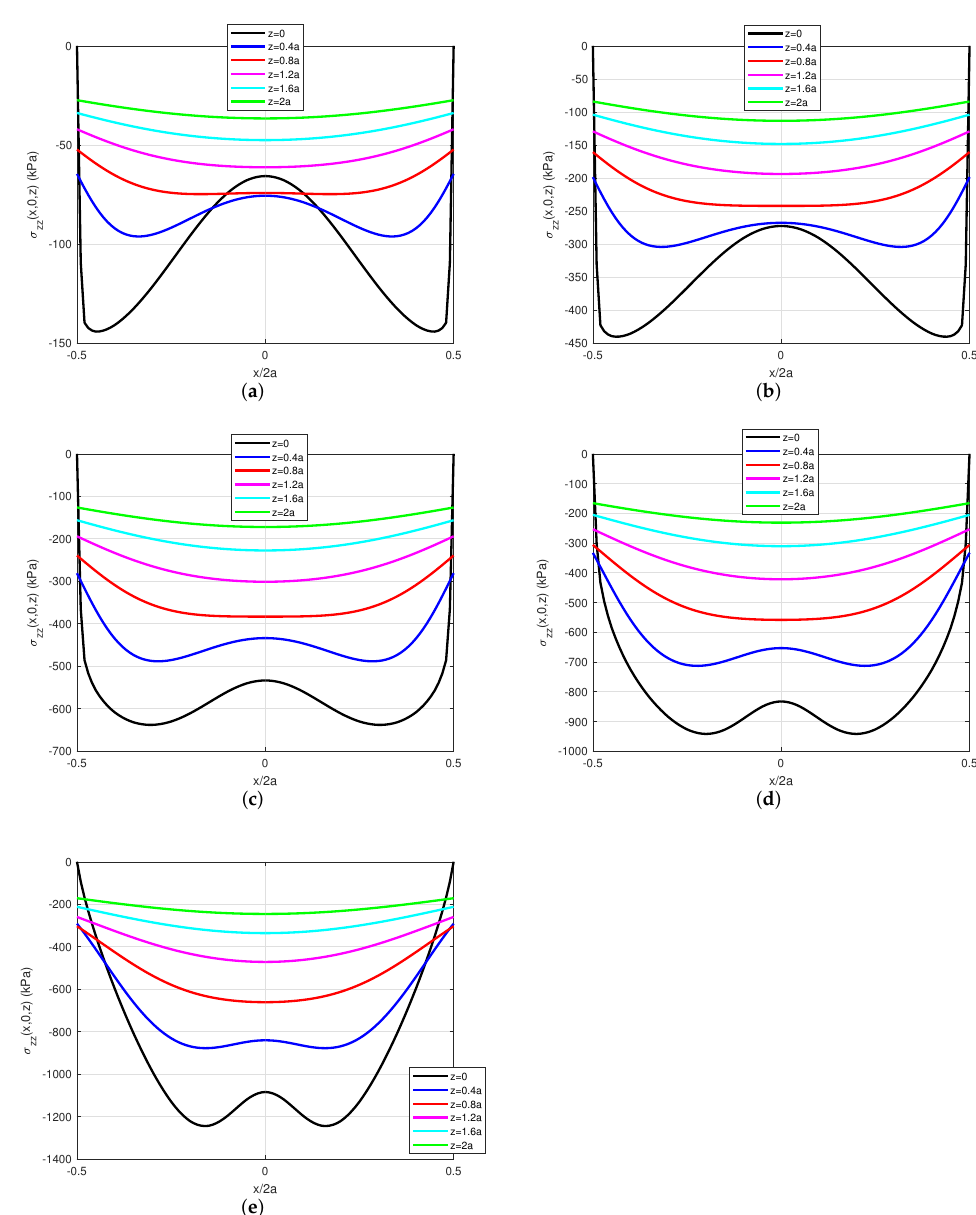
Figure 12. Vertical compressive stress σ zz in central cross sections with depth: ( a ) Case N1-T0.3; ( b ) Case N2-T0.3; ( c ) Case N3-T0.3; ( d ) Case N4-T0.3; ( e ) Case